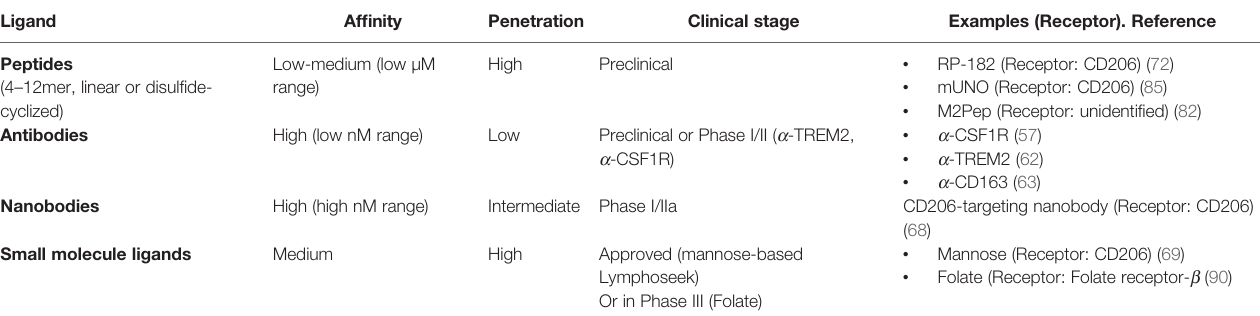
TABLE 2 | Ligands targeting M2-like